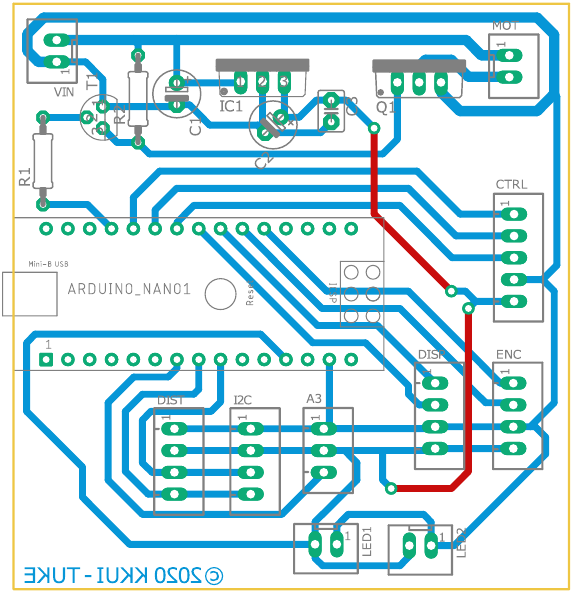
Figure 2. PCB design of plant’s control